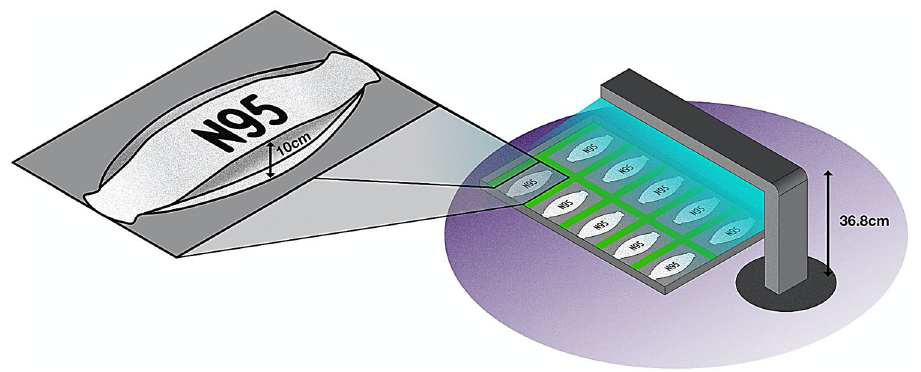
Figure 1. Full-scale setup of N95 respirators as arranged beneath a single arm of the UV light source. The maximum respirator height was measured to be 10 cm. The top of the respirator closest to the light source receives 1142 mJ cm −2 , and the bottom of the respirator farthest from the light source receives 1000 mJ cm −2